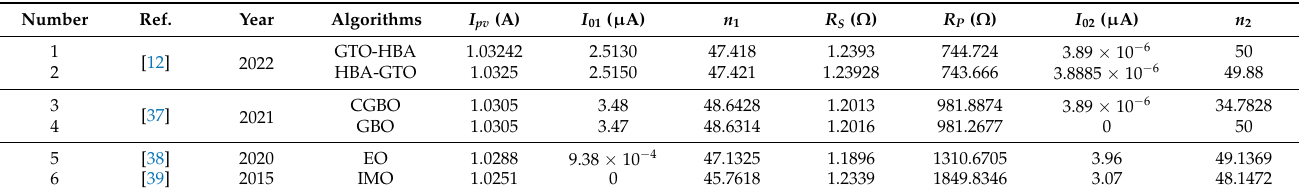
Table 3. DDM parameters for Photowatt-PWP solar